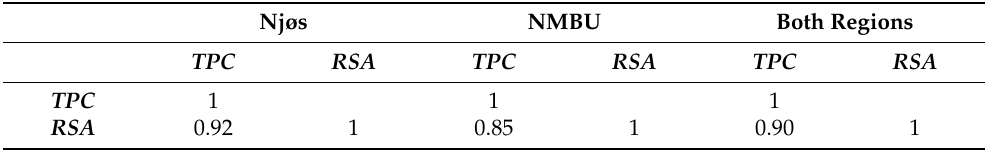
Table A1. Correlation between the average values of TPC (g GAE/kg) and RSA (mmol TE/kg) in 18 raspberry extract samples during the two-year collection from two Norwegian regions. ( p <